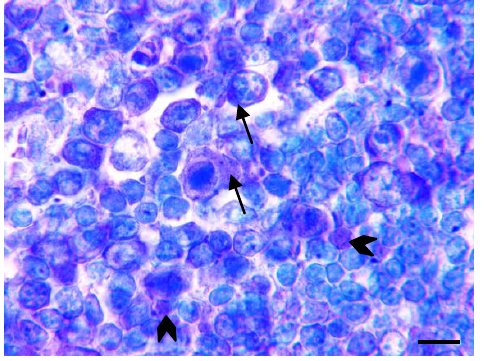
Figure 6: Microscopic view of a lymph node Figure 7: Microscopic view of a cow lung tissue section of a cow infected with infected with Theileria annulata parasites parasites shows the showing marked interstitial and alveolar emphysema associated with thickening of (arrow heads) or interalveolar septa. H and E stain, sinusoidal